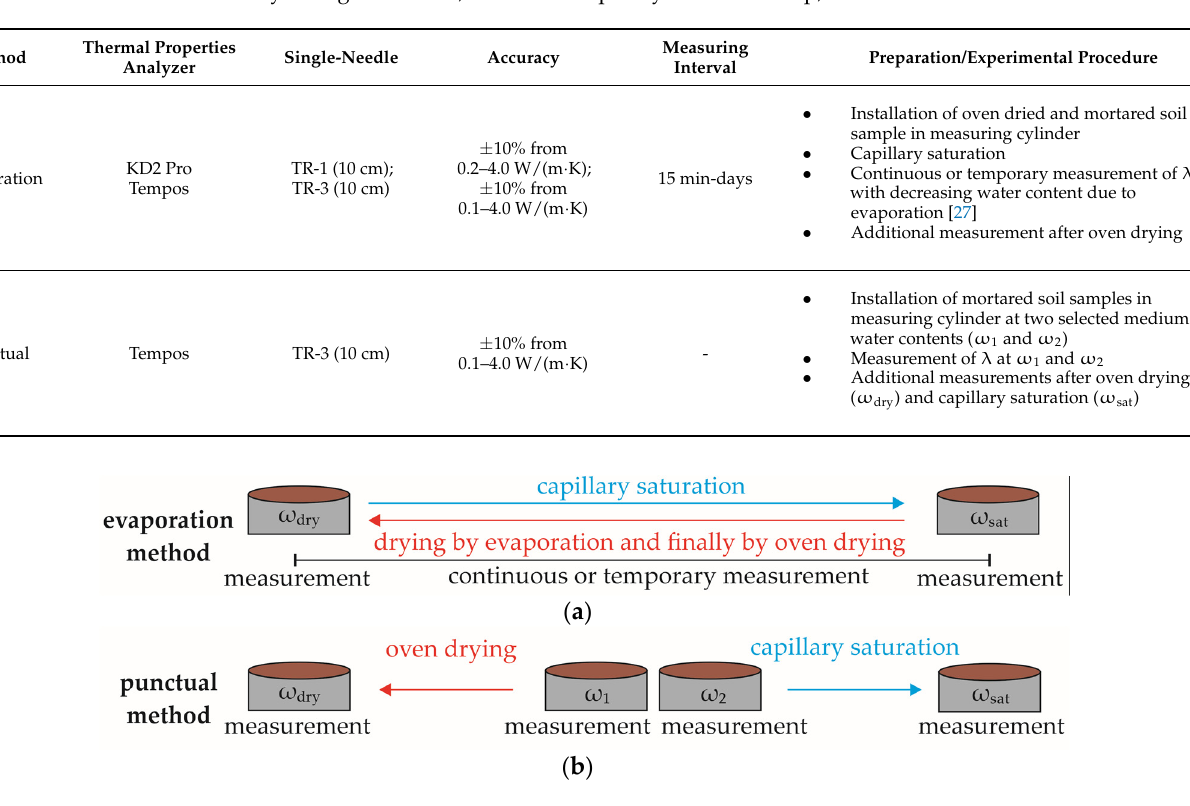
Figure 2. Schematic illustration of the procedure for thermal conductivity ( λ ) measurements explained in Table 2 with ( a ) evaporation method based on Markert et al. [27] and ( b ) punctual method with measurement of λ at four selected gravimetric water contents ( ω ): medium water contents ( ω 1 and ω 2 ), water content after oven drying ( ω dry ) and water content after capillary saturation ( ω sat ). The selection of the water contents ω 1 and ω 2 was based on the results of the evaporation method.